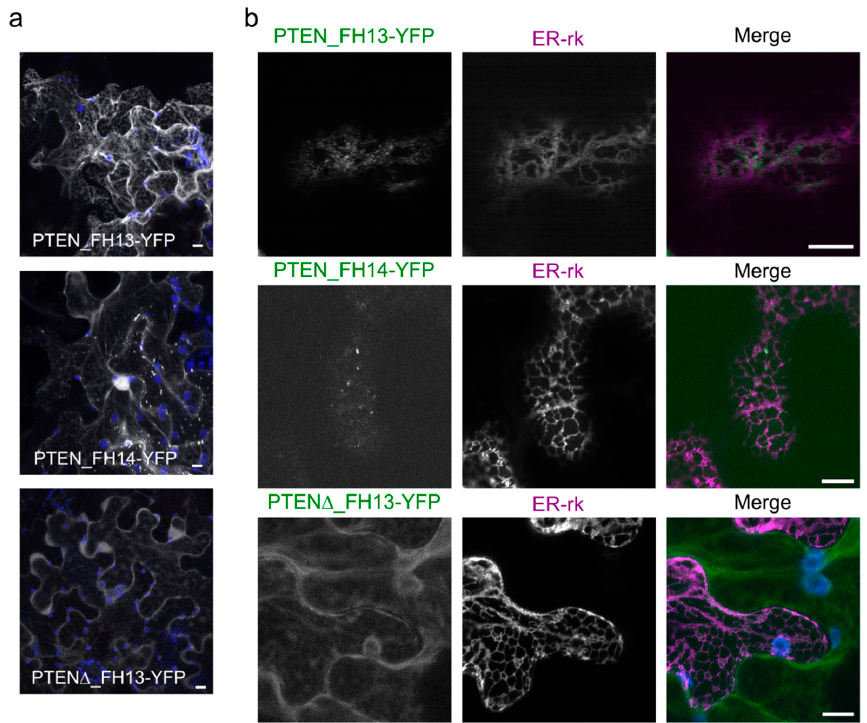
Figure 8. Localization of isolated PTEN domains of AtFH13 and AtFH14 in tobacco epidermal cells. ( a ) Maximal intensity projections of Z-stacks of optical sections from epidermal cells expressing PTEN_AtFH13-YFP, PTEN_AtFH14-YFP, or PTEN Δ _AtFH13-YFP. Yellow (YFP) signal shown in grayscale, chlorophyll autofluorescence in blue. ( b ) Single optical sections of cells co-expressing PTEN_AtFH13-YFP, PTEN_AtFH14-YFP, or PTEN Δ _AtFH13-YFP with ER-rk. Images from single channels are shown in grayscale, merged images display an overlay of three channels represented by green (YFP), magenta (RFP), and blue (chloroplast autofluorescence). Scale bars are 10 µm. Construct abbreviations are defined in the text and in Figure 1.